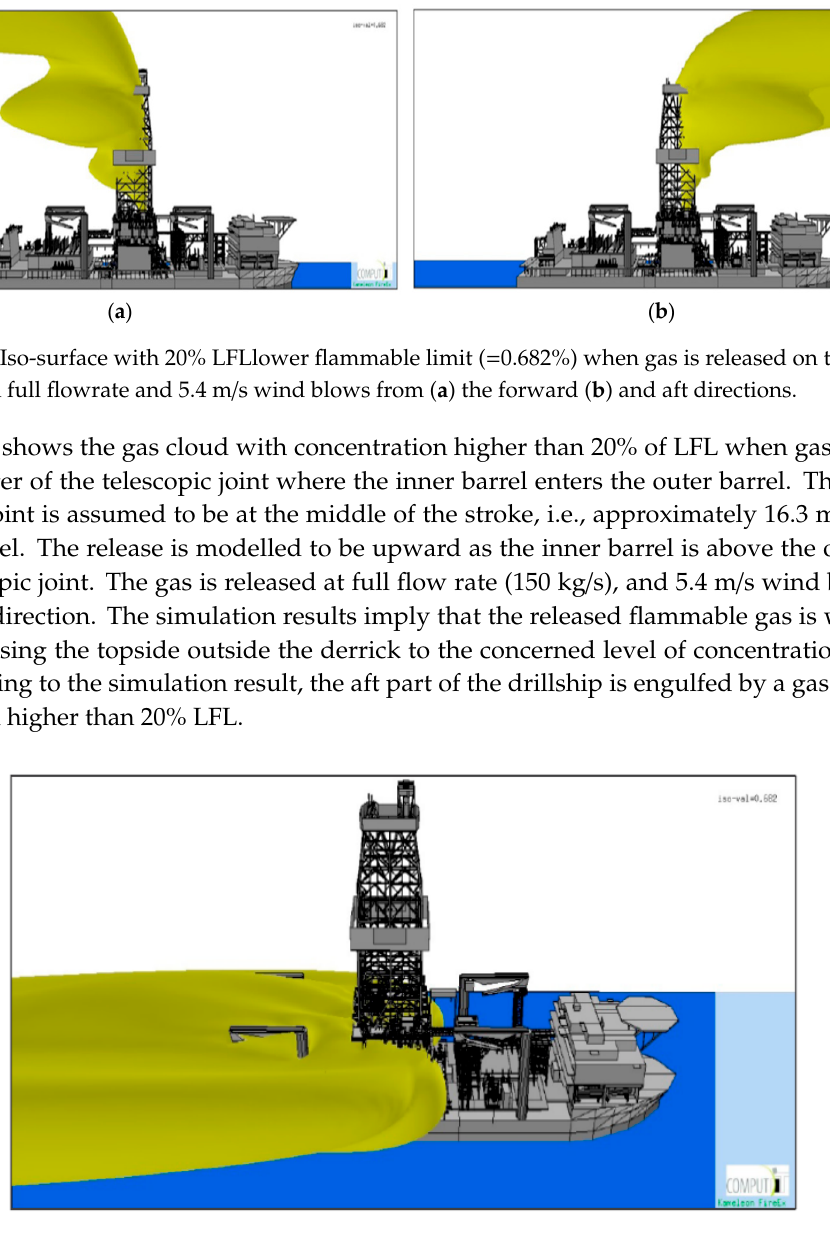
Figure 6. Iso-surface with 20% LFL ( = 0.682%) when gas is released under the drill floor with full flow rate and 5.4 m / s wind blows from the forward direction. Figure 7. ( a ) Visualization of flame 1.117 s after the gas cloud filling 50% of the derrick volume is ignited at the center of the bottom surface. ( b ) Visualization of flame 2.106 s after the gas cloud filling 30% of the moon pool volume is ignited at the aft starboard bottom corner.